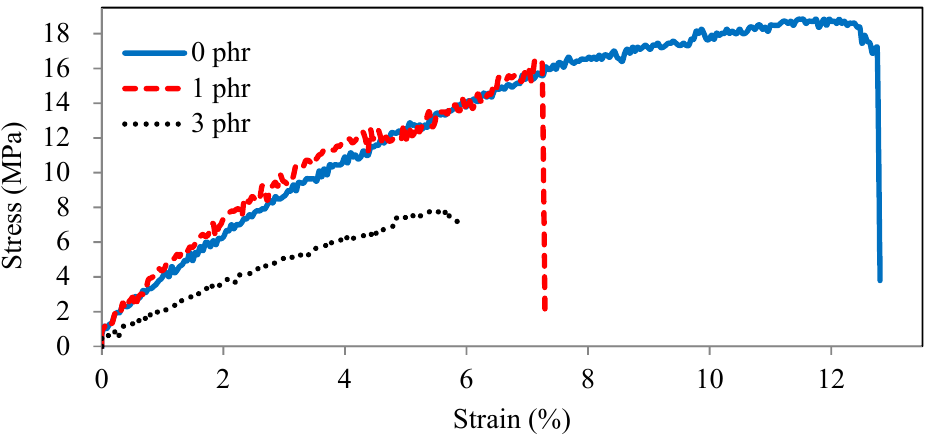
Figure 7. Stress–strain curves of ROL films with various A. confusa heartwood extractive additions.